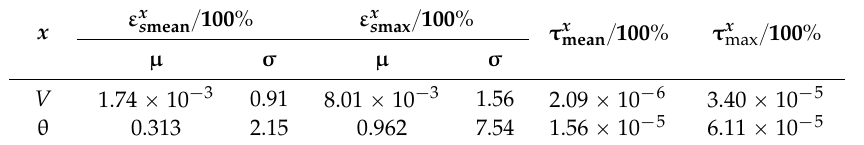
Table 7. Mean and maximum ERs and ARMSs of 3-order SG-PLF.